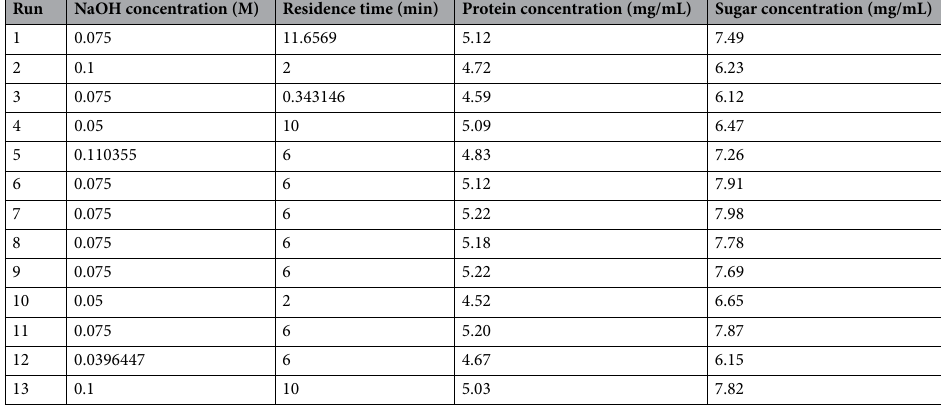
Table 2. Central composite design of microwave-alkaline hydrolysis and the corresponding responses.